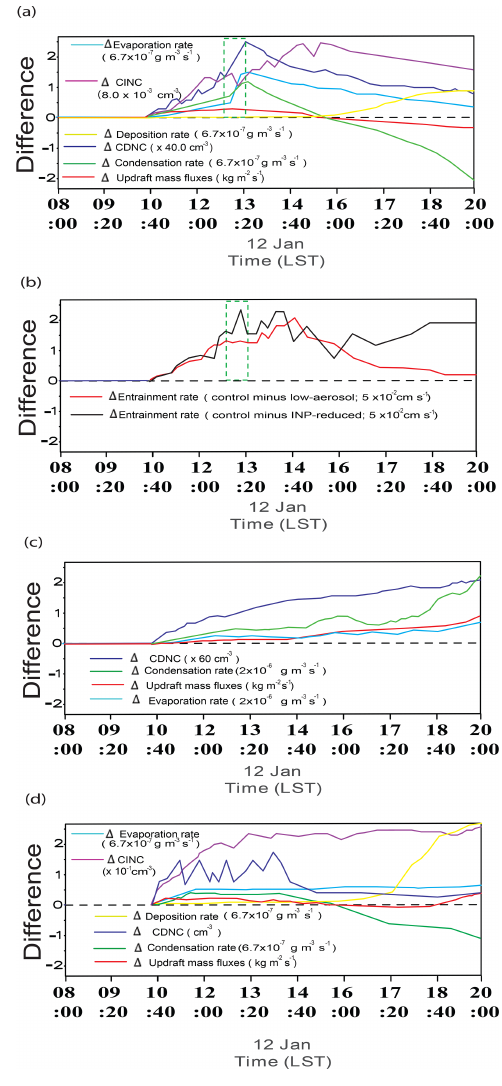
Figure 11. (a) Time series of differences in the domain-averaged updraft mass fluxes, deposition, condensation, and evaporation rates, the average CDNC (CINC) over grid points with non-zero CDNC (CINC) between the control and low-aerosol runs (the con- trol run minus the low-aerosol run). (b) Time series of differences in the average entrainment rate over all grid points at the PBL tops between the control and low-aerosol runs (the control run minus the low-aerosol run) and between the control and INP-reduced runs (the control run minus the INP-reduced run). (c) Same as (a) but between the control-noice and low-aerosol-noice runs (the control- noice run minus the low-aerosol-noice run) and (d) same as (a) but between the control and INP-reduced runs (the control run minus the INP-reduced run). Dashed lines in (a) , (b) , (c) , and (d) repre- sent zero differences. In (c) , due to the absence of ice processes in the noice runs, differences in deposition rates and CINC are absent. A green dashed box in (a) and (b) marks a time period when steady and rapid temporal increases in the CDNC differences and a jump in differences in each of condensation and evaporation rates between the control and low-aerosol runs occur (see text for